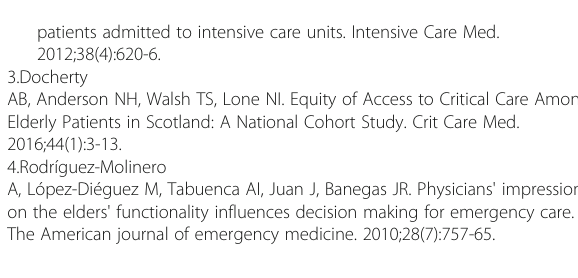
Table 1.). The MELD score and PNI were 0.793 and 0.712, respectively. The INR and serum bilirubin were 0.705 and 0.637, respectively. The mPNI was the highest predictive value for development of AKI within 1-week after LT.